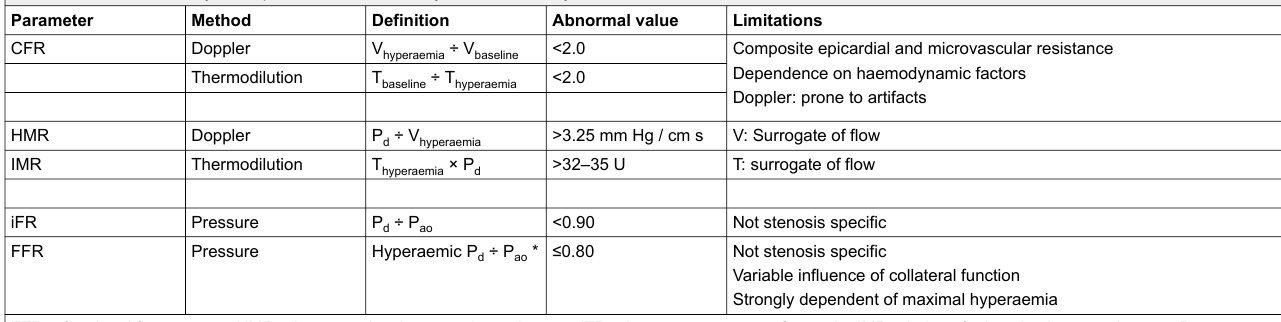
FFR = fractional flow reserve; HMR = hyperaemic microvascular resistance; iFR = instantaneous wave-free ratio; IMR = index of microcirculatory resistance; P ao = mean aortic pressure; P d = distal mean coronary pressure; T = mean transit time *: mean pressures obtained during the entire cardiac